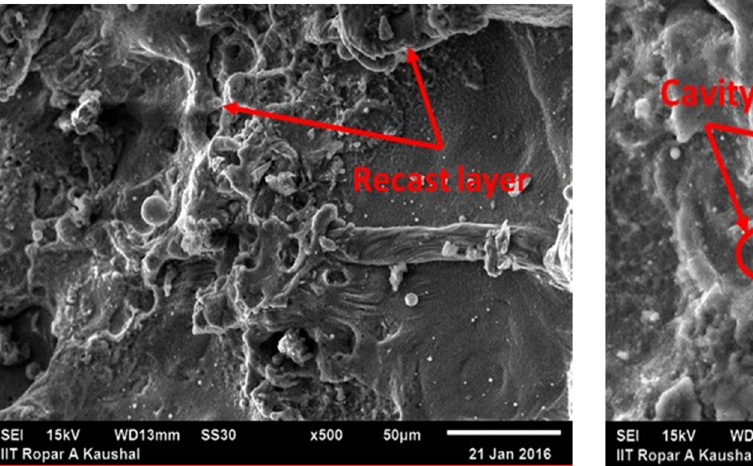
Figure 7: SEM image of Al/20 wt%SiC/8 wt%Gr – MMC hybrid com - posite after machining.